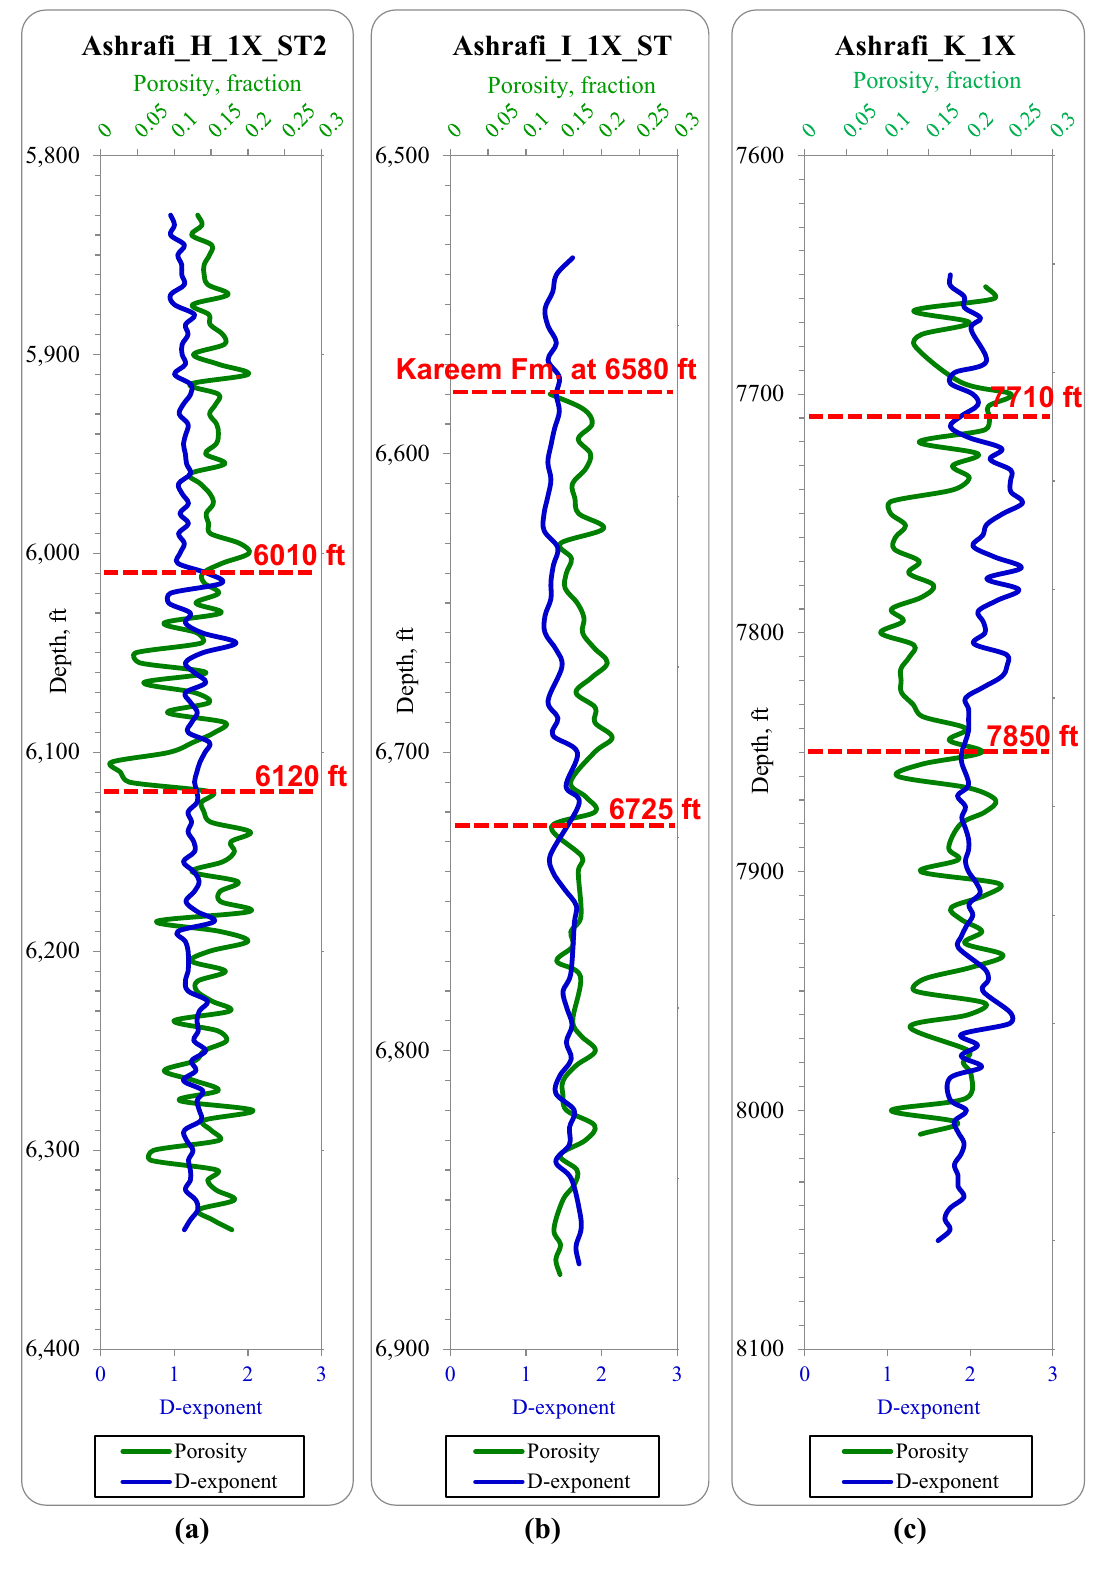
Fig. 6 D -exponent and porosity log with depth relationship. a Ashrafi_H_1X_ST2, b Ashrafi_I_1X_ST, and c Ashrafi_K_1X. The red dashed lines represent the possible overpressure